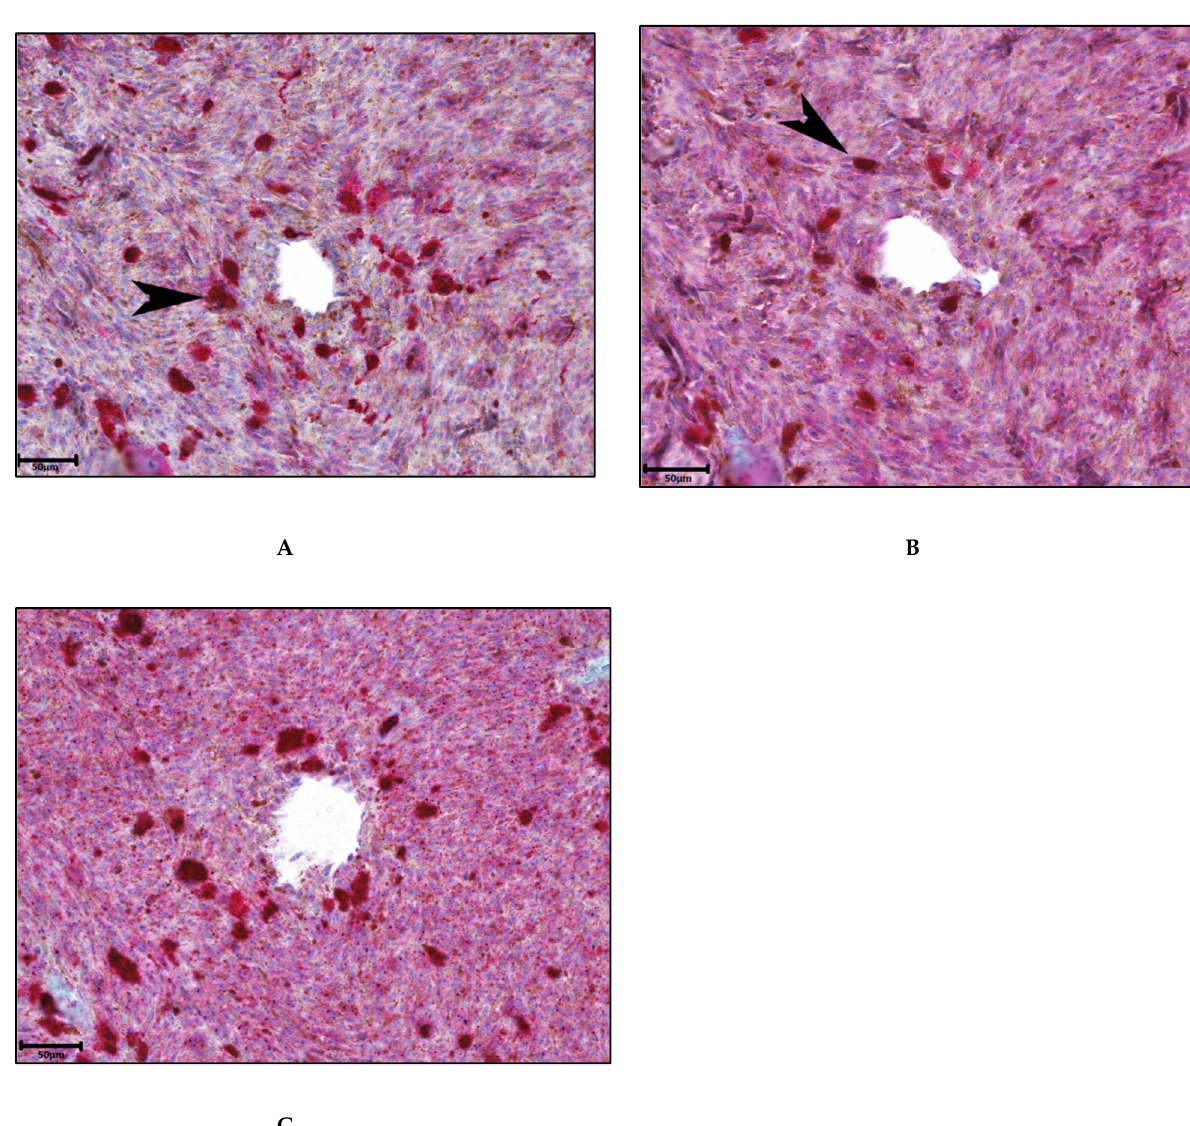
Figure 4. Representative immunohistochemical analysis to determine the expression of ANG-2 and infiltration of T-cells and M2 macrophages in primary tumor material: Scale bar is 50 um. ( A ) CD163 expression to identify M2 macrophages (black arrow); ( B ) CD3 to identify lymphocytes (black arrow); ( C ) ANG-2 expression (original magnification 10.0 × , red chromogen).